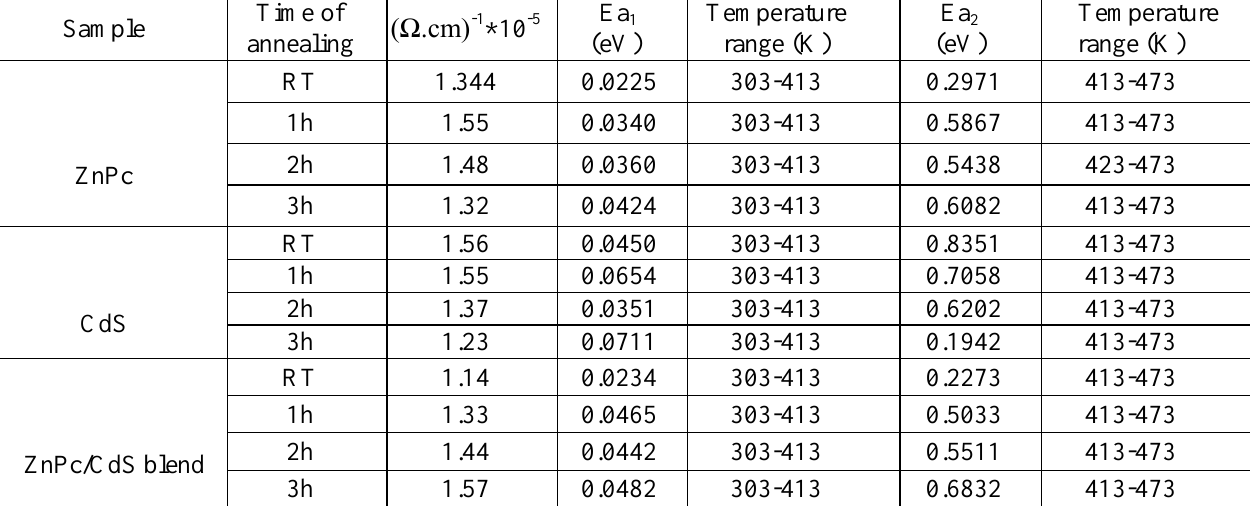
Table 3: The values of E and E and these ranges for as-deposited and annealed ZnPc, a1 a2 CdS and ZnPc/CdS blend films for 423K with different annealing